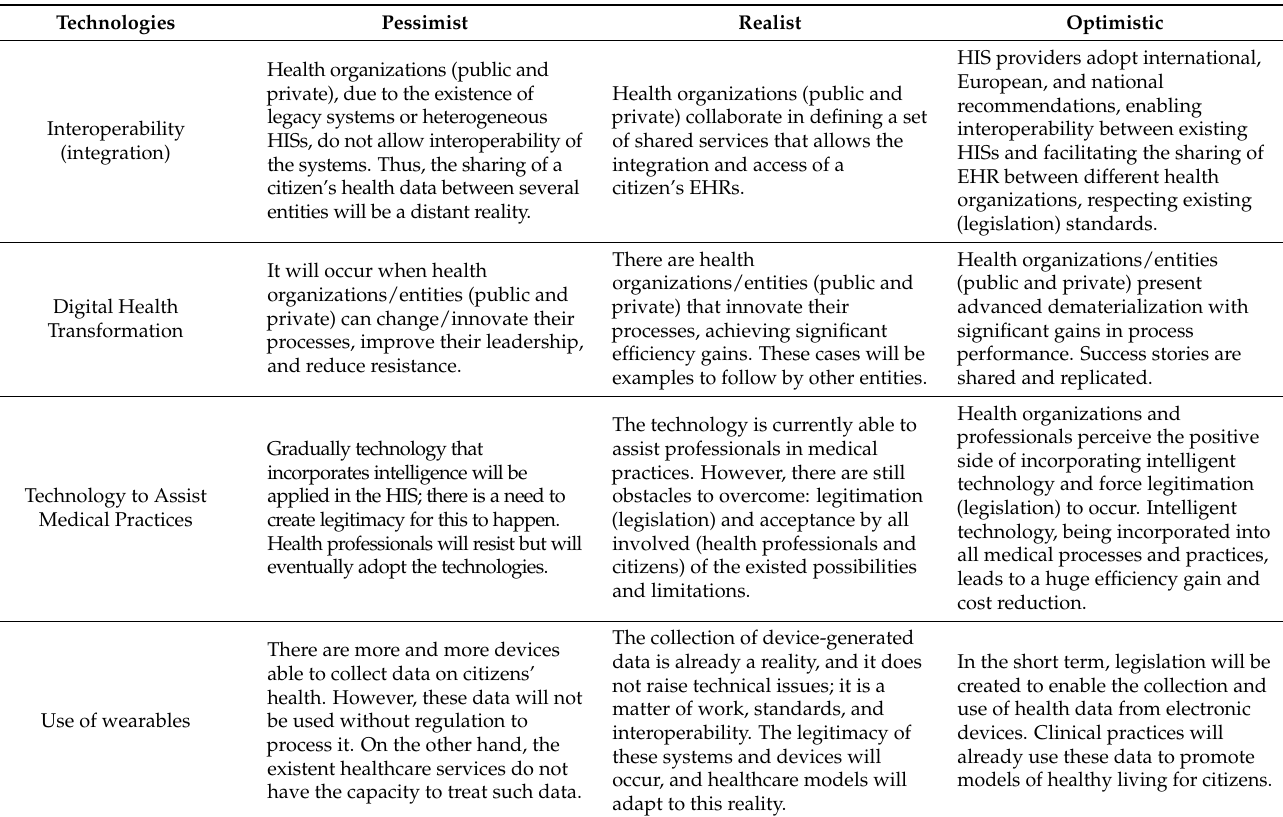
Table 4. Scenarios for